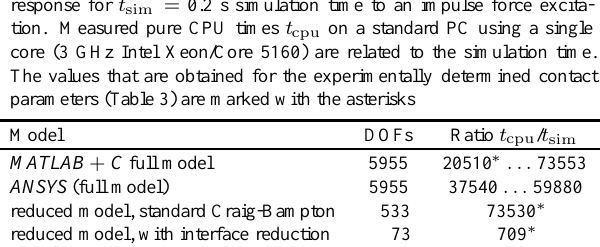
Table 2 Evaluation of the computation times for the calculation of a